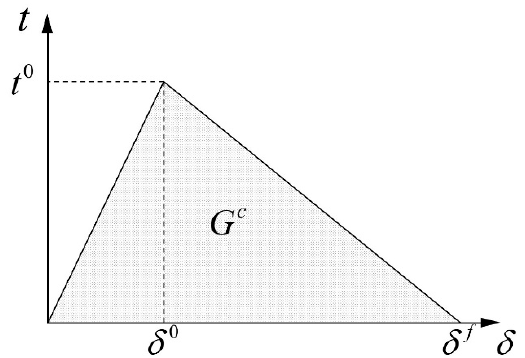
Figure 1. Stress-displacement curve of bilinear traction-separation law.